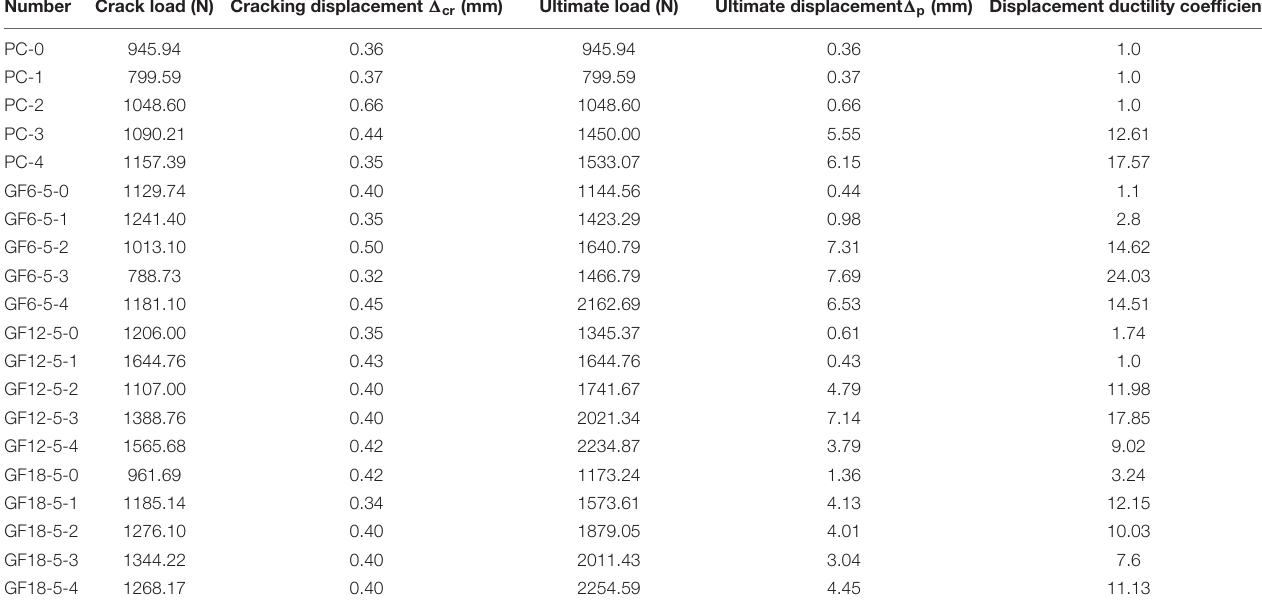
TABLE 5 | The main results of sheet bending